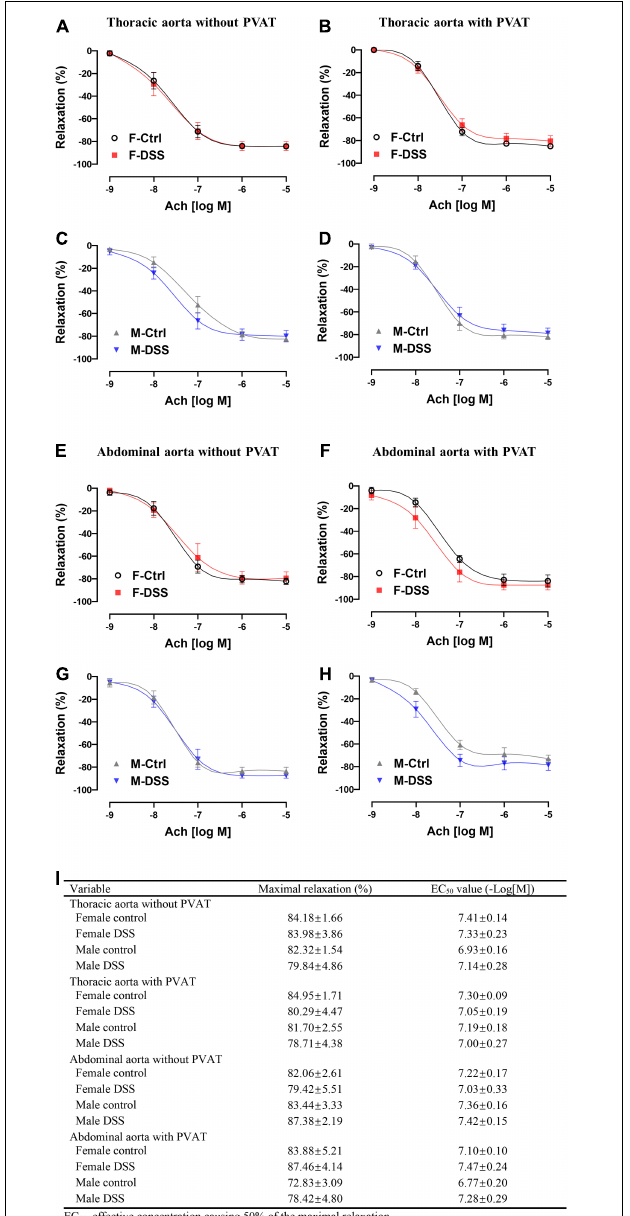
FIGURE 5 | Ach-induced endothelium-dependent relaxation of abdominal aorta was selectively impaired in female mice with DSS-induced chronic colitis. (A–D) Ach-induced endothelium-dependent relaxation of thoracic aorta with or without PVAT. (E–H) Ach-induced endothelium-dependent relaxation of abdominal aorta with or without PVAT. (I) Maximal relaxation and EC 50 for Ach were calculated in the table. Results are expressed as means ± SEM. * p < 0.05, in two-way ANOVA followed by Bonferroni correction (A–H) , n = 5–8 mice in each group. PVAT, perivascular adipose tissue; F and M, female and male mice, respectively. Ach,